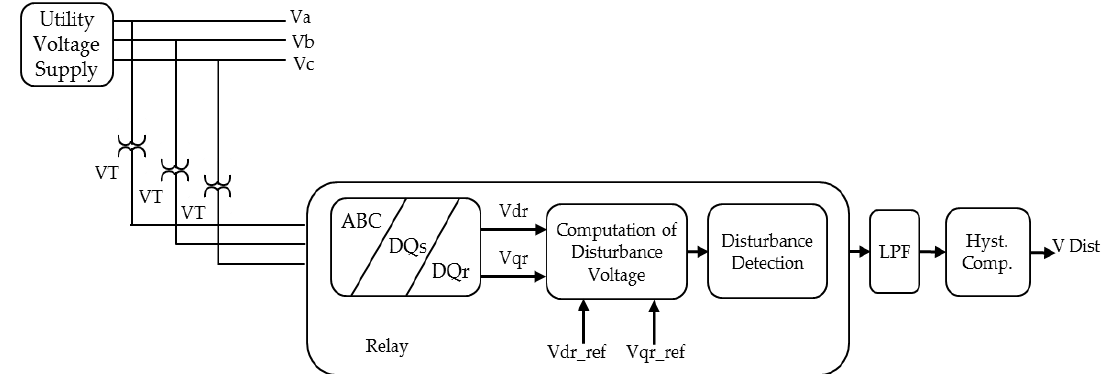
Figure 8. Typical implementation of voltage based protection scheme .